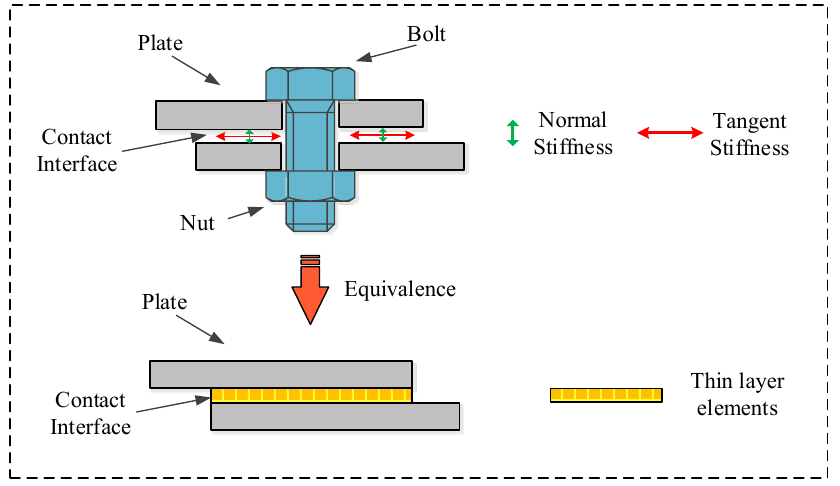
Figure 9. The first four order experimental modal shapes under different pre‐tightening torque.